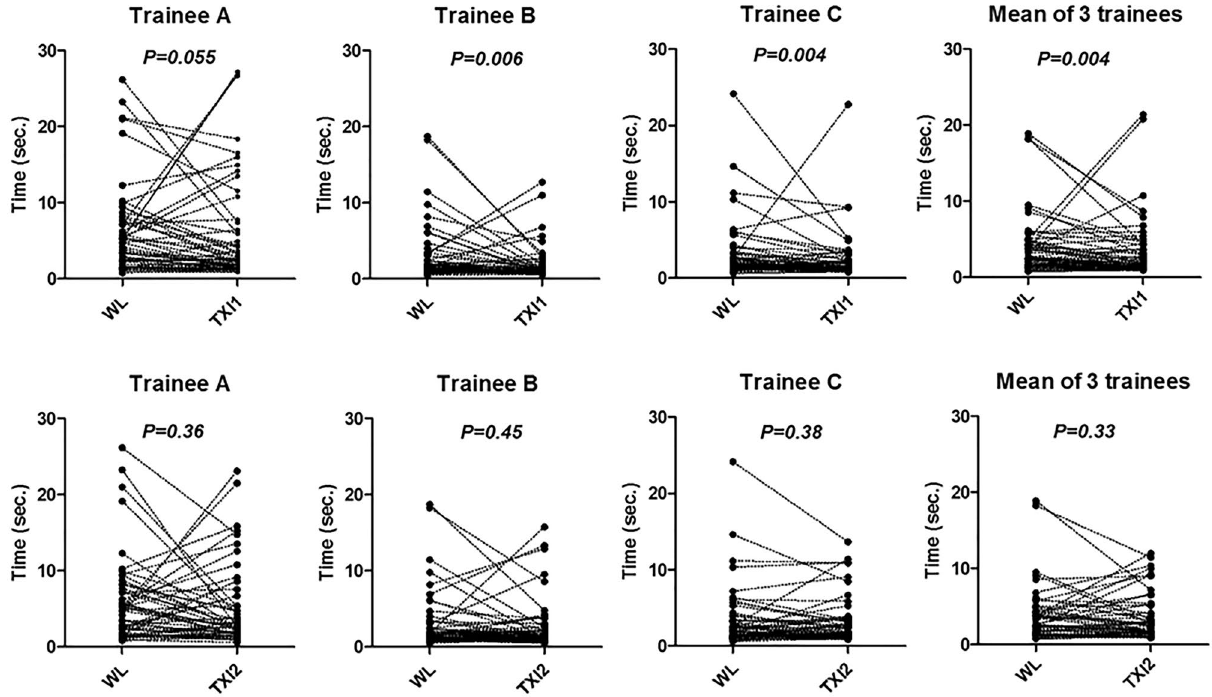
Figure 3. Comparison of lesion detection time between WL, TXI1 and TXI2 in three trainee endoscopists. Statistical analysis was performed using the Wilcoxon signed rank